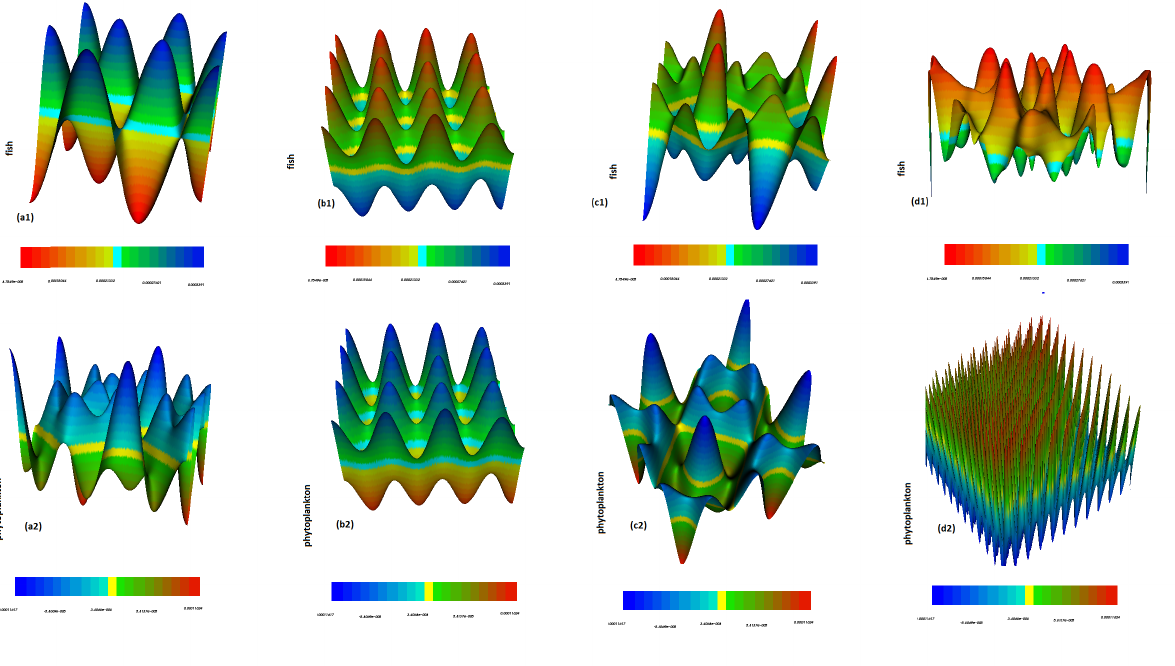
Figure 5. Dynamic behavior of two dimensional space: fish [first line] and phytoplankton [second line] population density of the model system (4). The diffusion coefficient values are δ 0 = 0.3, δ 3 = 0.4. Spatial distribution are obtained at different values of θ p : for plot θ p = 0.35 ( a 1; a 2 ) ; θ p = 0.512 ( b 1; b 2 ) ; θ p = 0.82 ( c 1; c 2 ) ; θ p = 0.96 ( d 1; d 2